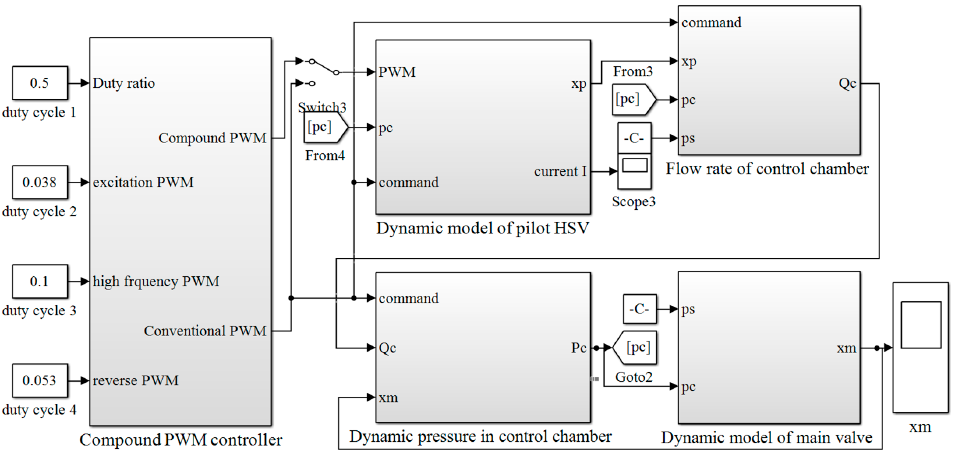
Figure 3. Simulation model of the AMOHSV. Table 1. Main parameters of the AMOHSV.